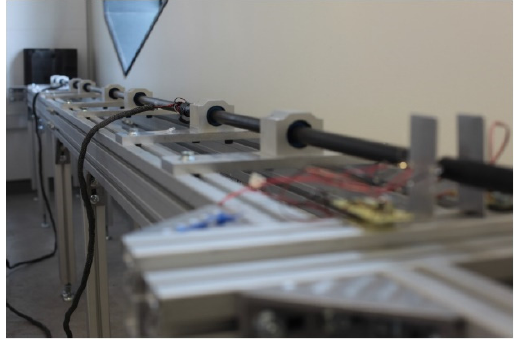
Figure 3. Developed Kolsky compression bar for elastomer testing.